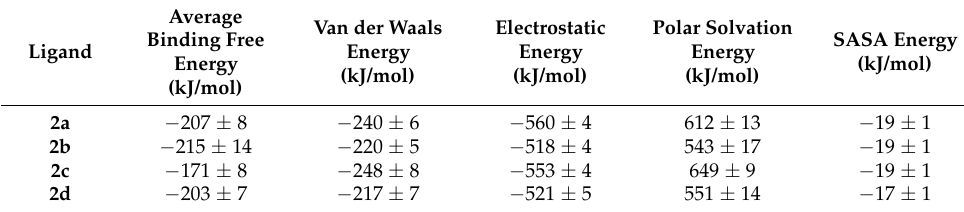
Table 4. Average binding free energy of the representative configurations of the different com-